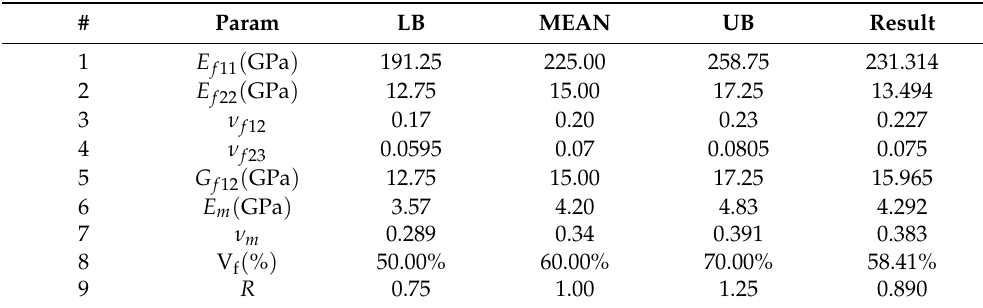
Table 10. The updated design variable parameters and design bounds (LB and UB) of the examined micromechanics